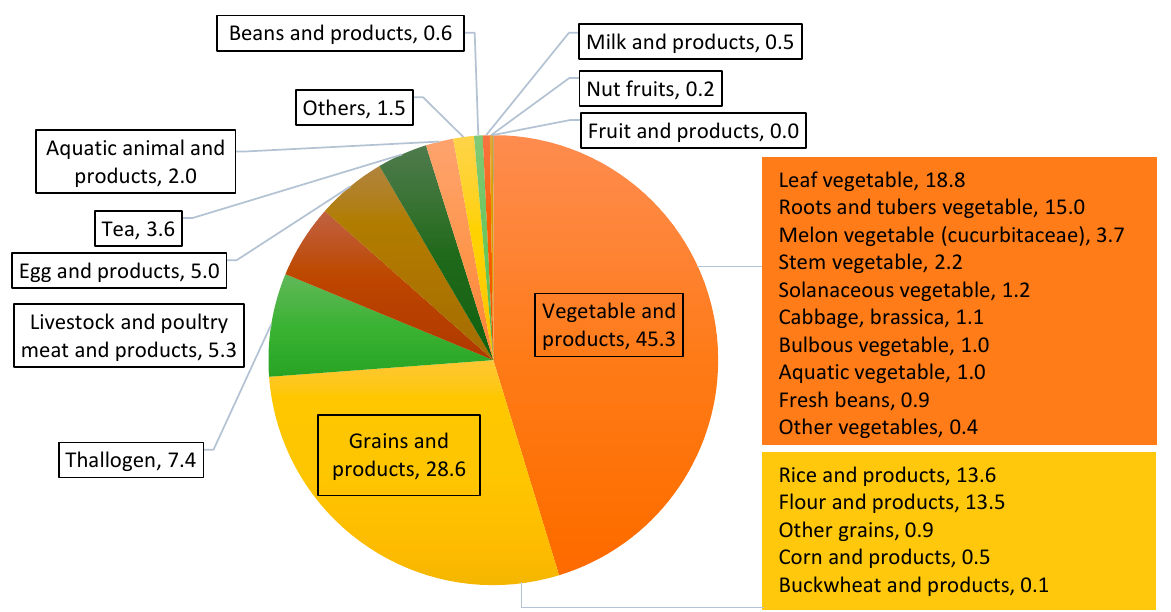
Figure 2. Percentage of mean total REEs exposure of different food categories to the tADI of REEs (51.5 μ g/kg BW) for the general population.